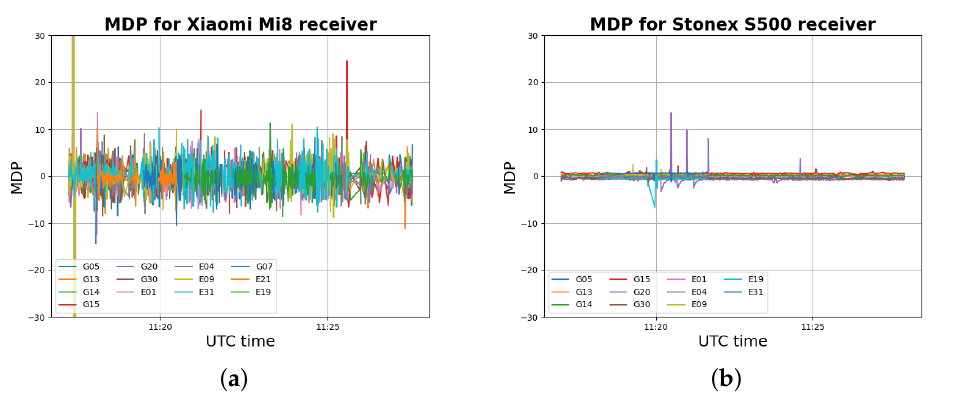
Figure 13. MDP values for Xiaomi Mi8 receiver ( a ) and for Ublox ZED F9P receiver ( b ) for a kinematic data set.